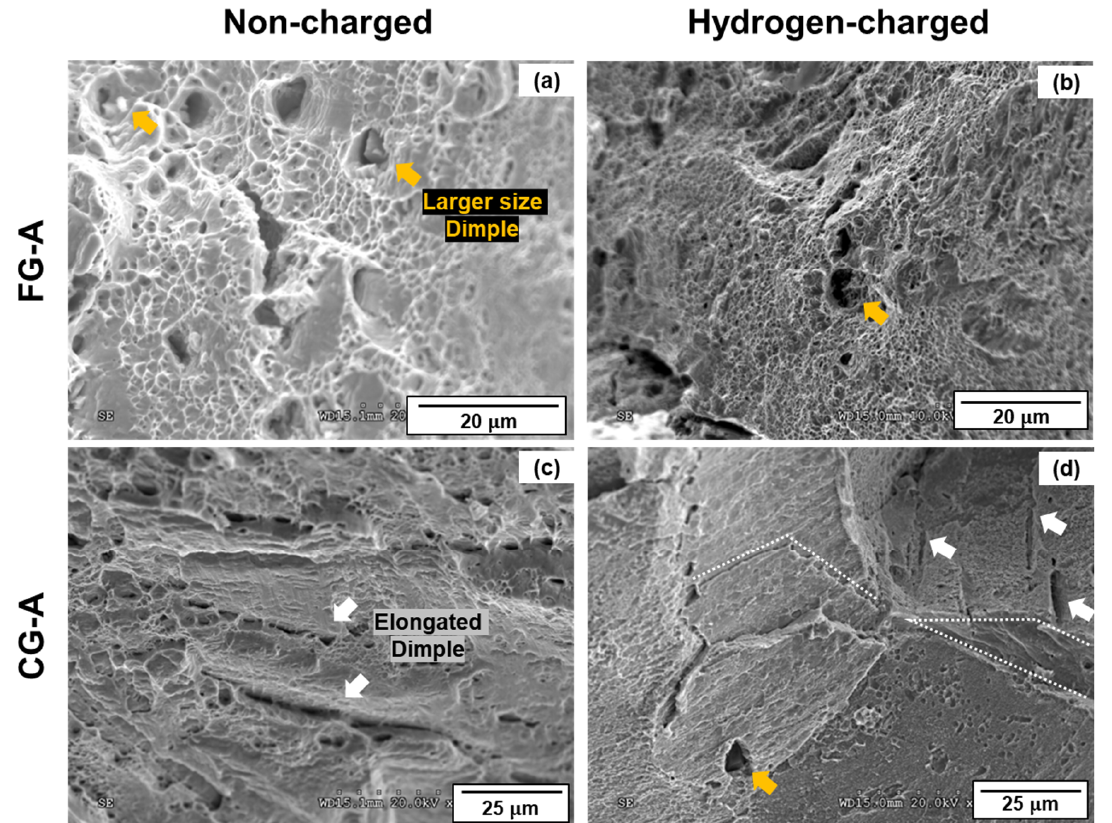
Figure 6. The magnified image ( a - d ) of each fractograph shown in Figure 5. The yellow arrows indicate dimples of larger size originating from primary block MC carbides, on the other hand, the white arrows show elongated dimples that appeared only in CG-A specimens.